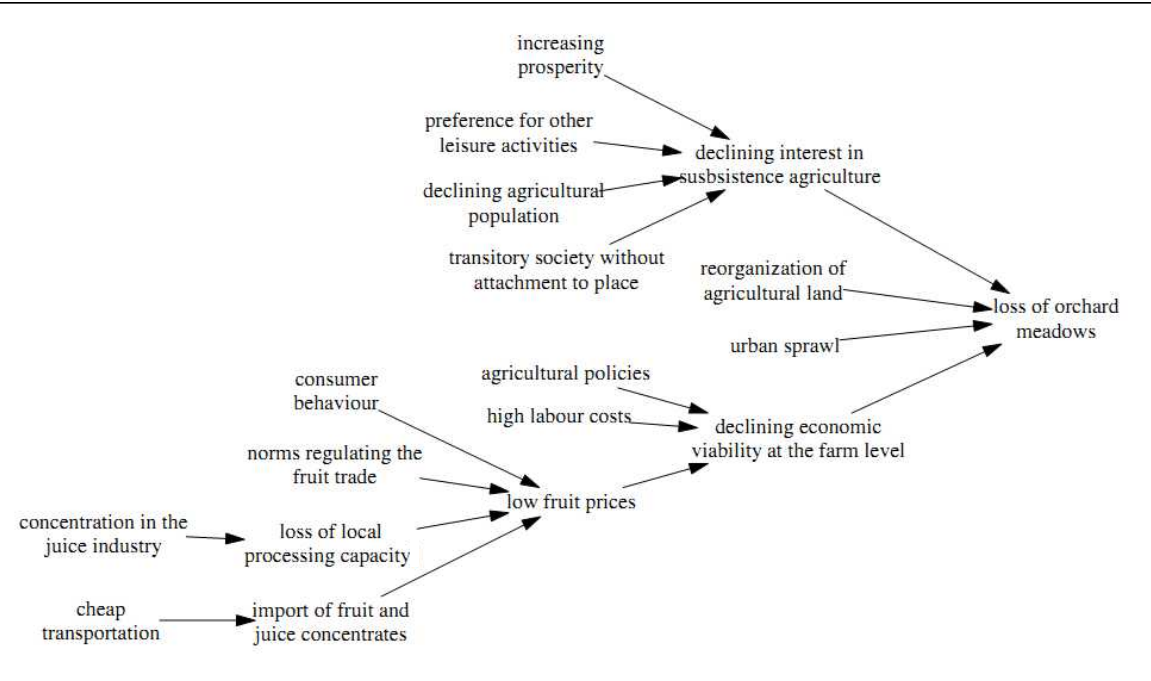
Figure 3. The Initial Conceptual Model of Orchard Meadow Decline, Based on the Literature